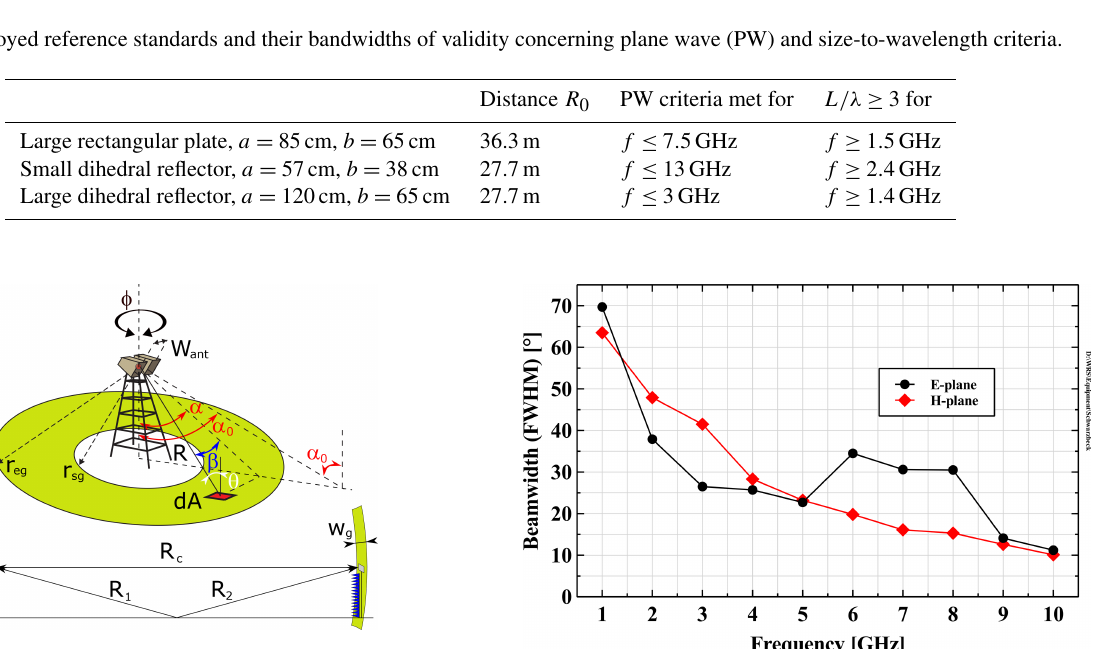
Figure B2. Schematic of scatterometer geometry. (a) Every in- finitesimal area d A has its own distance R to the geometric cen- tre between antenna apertures (red dot) and angle of incidence θ . Angles α and β lie within the antennas principal planes, and α 0 de- notes the angle of antenna boresight. The green ring is a projection of the spherical gating shell with radii r sg and r eg onto the ground. (b) Side view of geometry during measurement of reference stan- dards. Green ring depicts cross section of spherical gating shell with width w g .